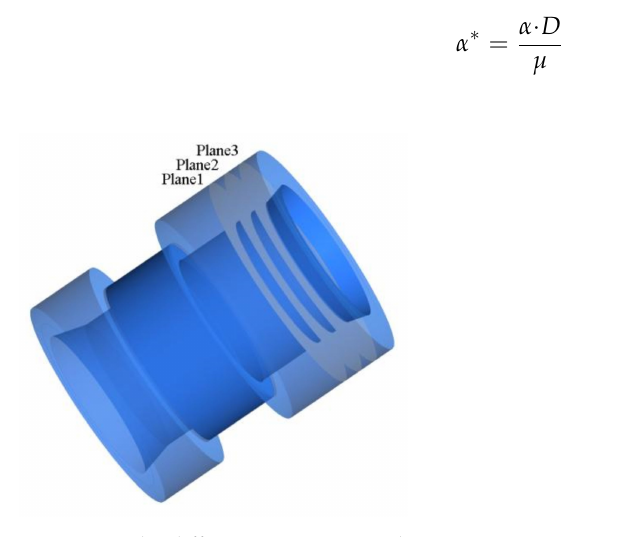
Figure 15. The different cross-sectional